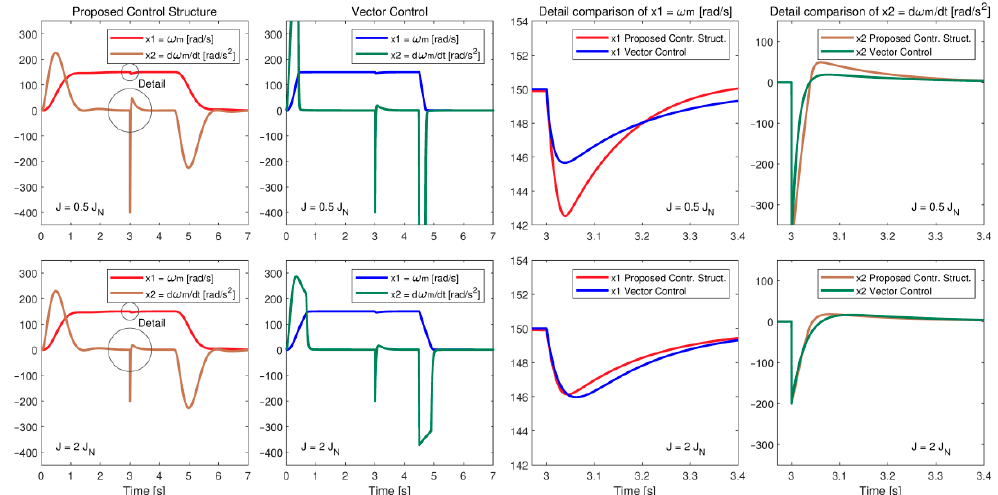
Figure 13. Comparison of proposed control structure and vector control for moment of inertia changed to J = 0.5 J N and J = 2 J N .